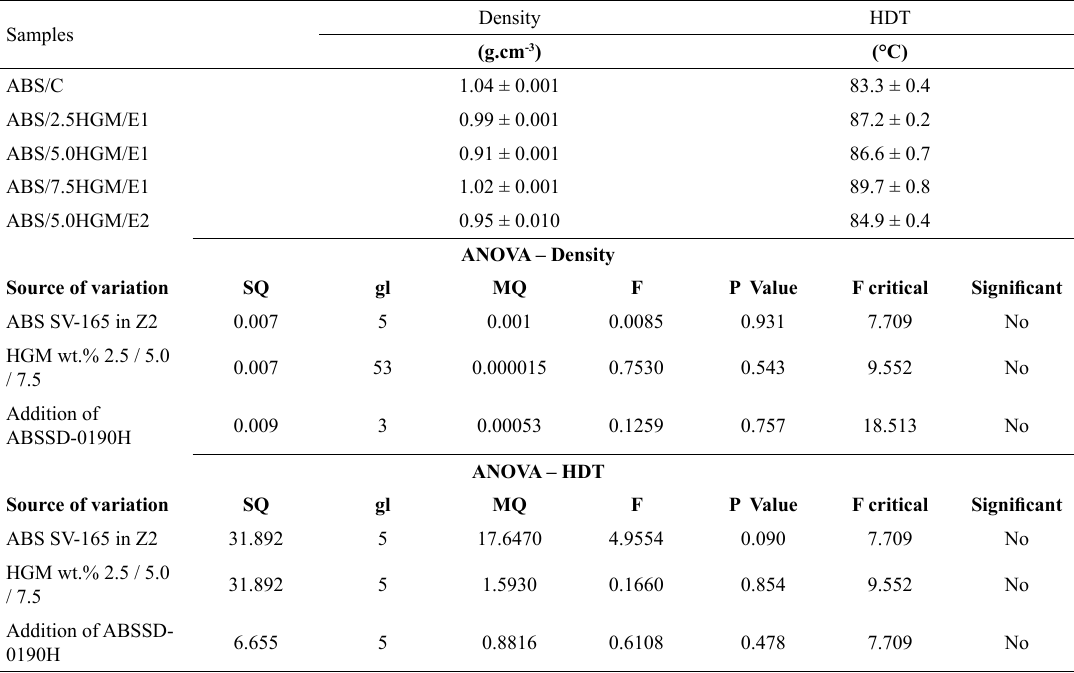
Table 2. Density and HDT of the composites as a function of HGM content with statistical analysis of the samples studied.